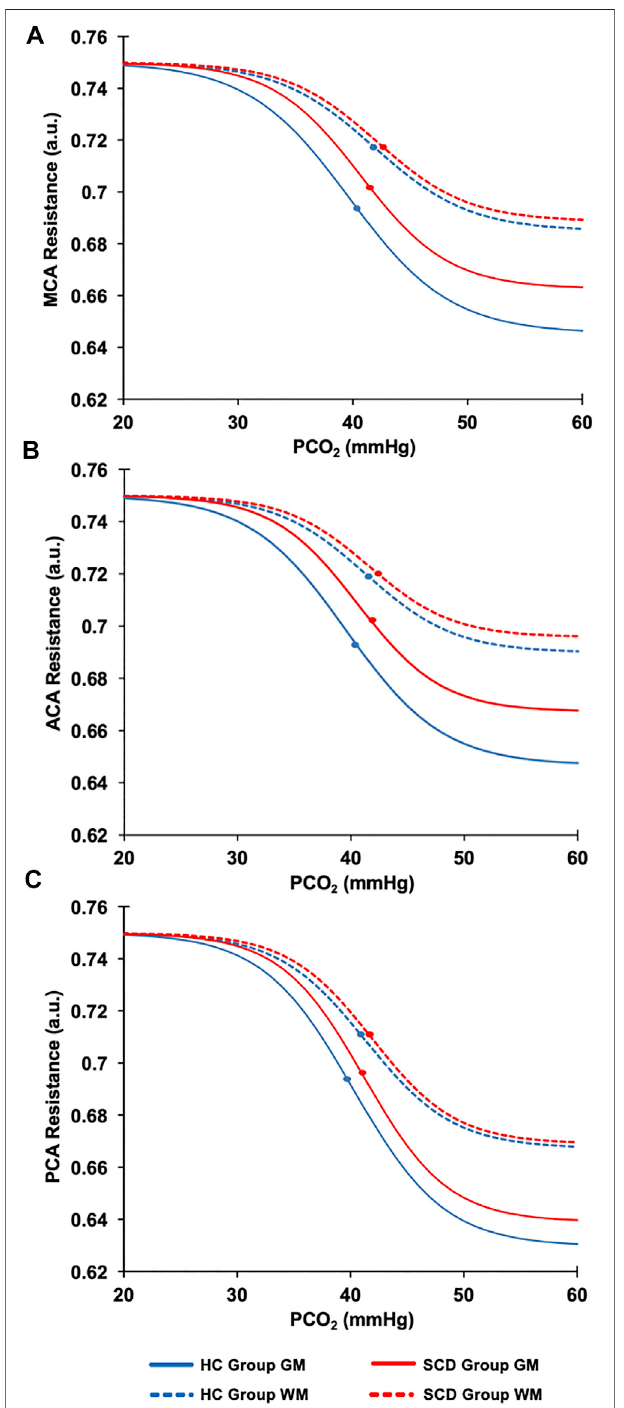
FIGURE4| TheresistancesigmoidalcurvesfortheHC(blueline)andtheSCD patient(redline)groupsinGM(solidlines)andWM(dashedlines)calculatedfromthe meanvaluesoftheresistancesigmoidparameters. (A) TheMCAsigmoid curvesfor theGMandWMforHCandSCDpatientgroups. (B) TheACAsigmoidcurves fortheGMandWMforHCandSCDpatientgroups. (C) ThePCAsigmoidcurvesfor the GM and WM for HC and SCD patient groups. The dots on each sigmoid curve represent the resistance reserve (from the dot to the lowest resistance).